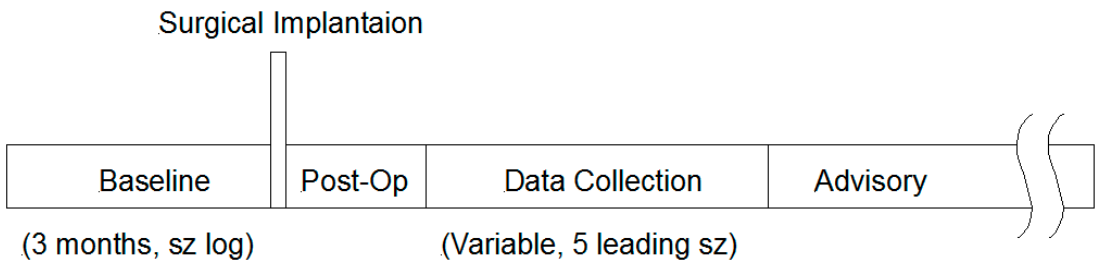
Figure 3. Study Timeline: After enrollment, the patients commence a three month baseline phase involving diligent seizure log maintenance, followed by surgical implantation of the SAS, post-op recovery, matriculation into a Data Collection Phase, then qualified entry into an Advisory Phase. Algorithms were tested both during the Data Collection Phase and the subsequent Advisory